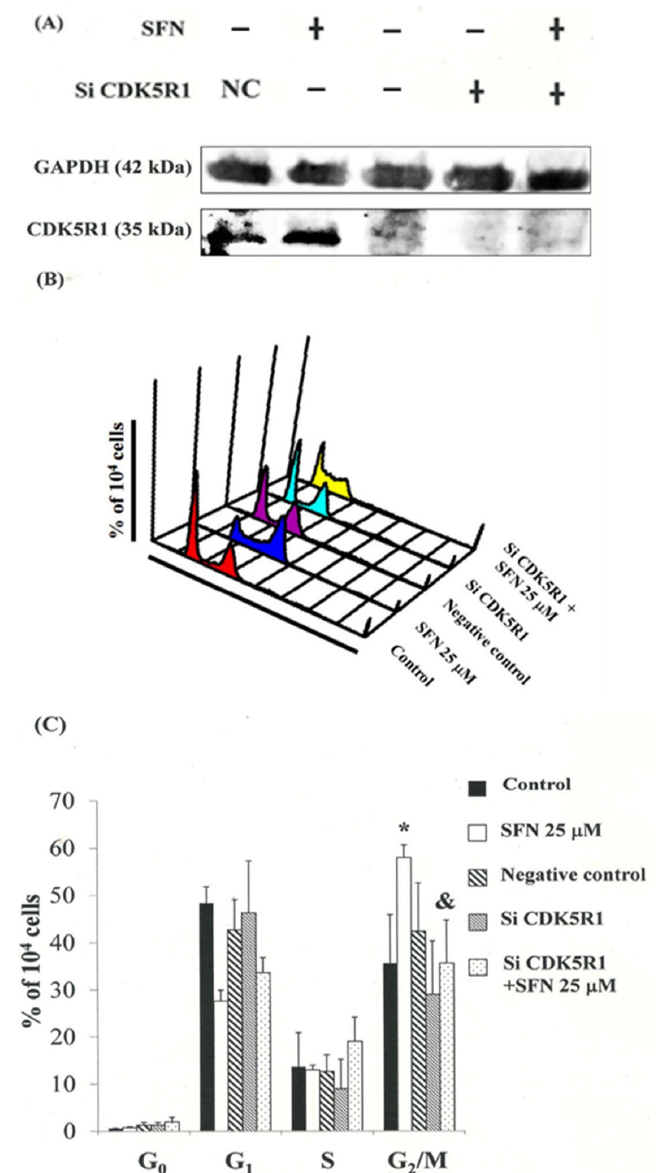
Figure 6. Re-enter cell cycle arrested by SFN in MDA-MB-231 and ZR-75-1 cells via inhibition of CDK5R1. ( A ) CDK5R1 in MDA-MB-231 and ZR-75-1 cells treated with SFN and/or CDK5R1 SiRNA. ( B ) Delay in mitosis in SFN-treated and/or reenter cell cycle CDKR1 SiRNA cells. ( C ) Cell cycle-phase percentage (%). Cells underwent staining with propidium iodide to analyze DNA content, which was quanti fi ed by fl ow cytometry. * in each group of bars indicates that the number of G 2 /M